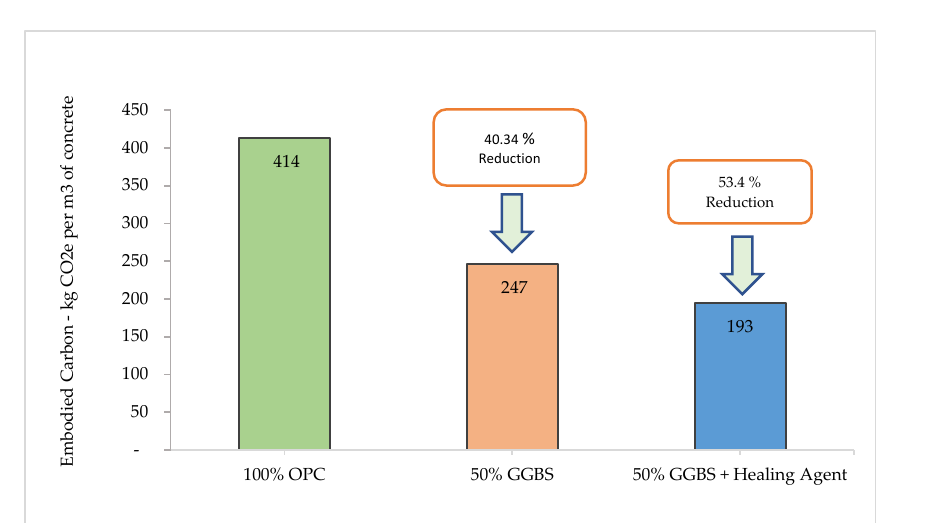
Figure 10. Embodied carbon in concrete—Comparison between mixes.